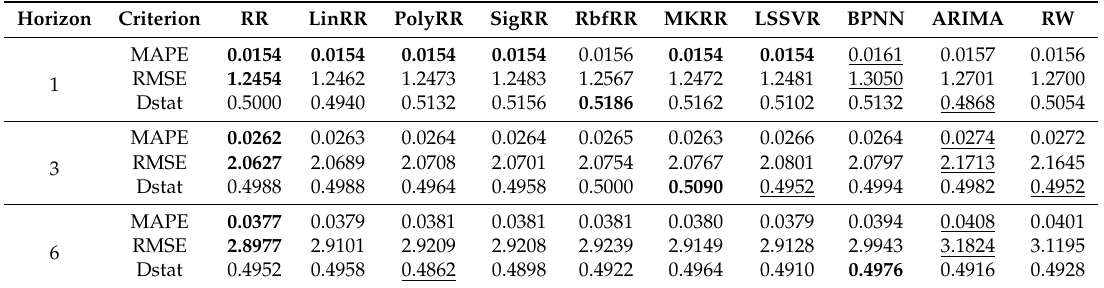
Table 2. Results of single